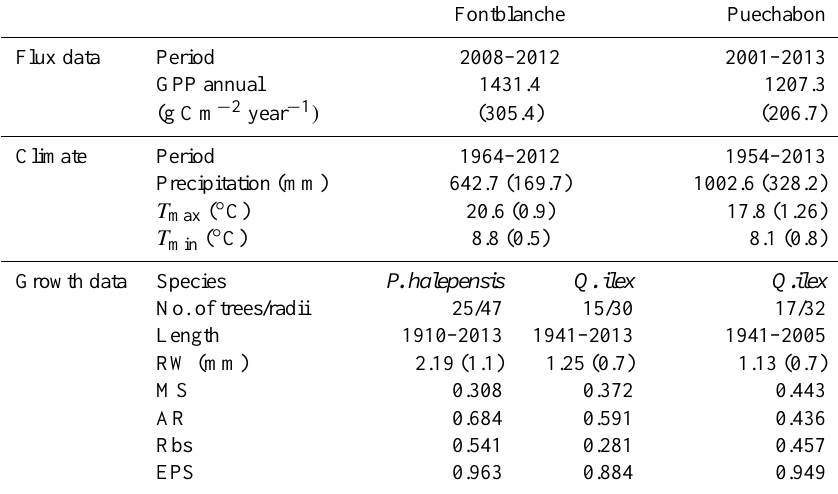
Table 1. Characteristics of mean annual gross primary productivity, climatic (annual means) and growth data. Standard deviations are shown in parentheses. Precipitation: mean annual precipitation; T max : annual mean of mean daily maximum temperature; T min : annual mean of mean daily minimum temperature; length: chronology year replicated with more than 5 radii; RW: mean annual ring width; Rbs: mean correlation between series; AR: mean autocorrelation of raw series; MS: mean sensitivity; EPS: mean expressed population signal. Rbs, AR, MS and EPS are classical statistics to characterize growth chronologies, and they follow Fritts